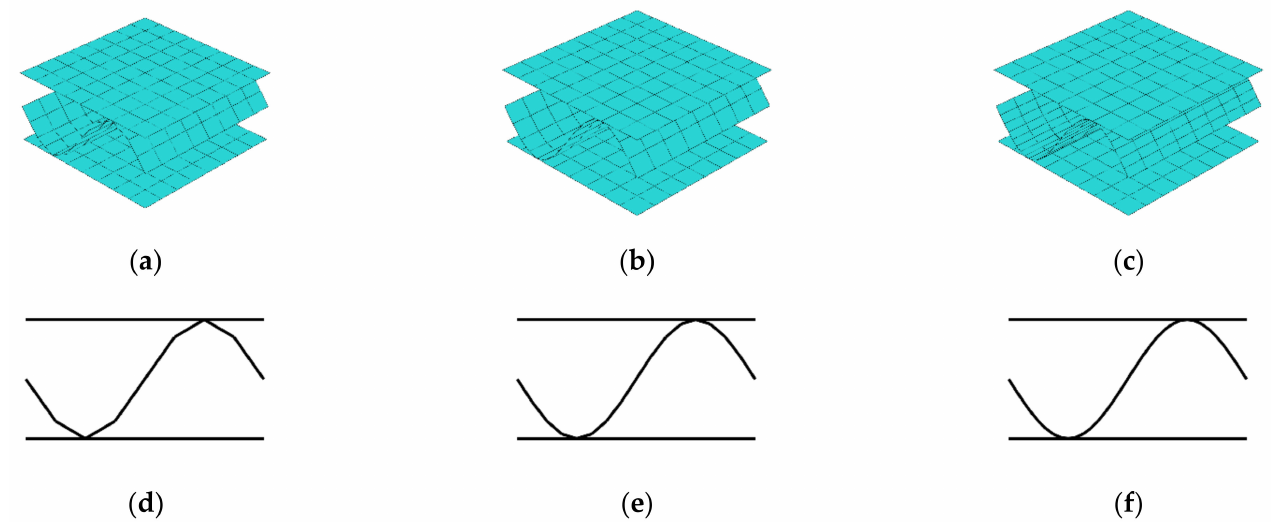
Figure 6. Different discretizations of cardboard fluting for unsymmetric RVE: ( a ) 8, ( b ) 16, and ( c ) 32 fluting segments; and corresponding cross-sections: ( d ) 8, ( e ) 16, and ( f ) 32 fluting